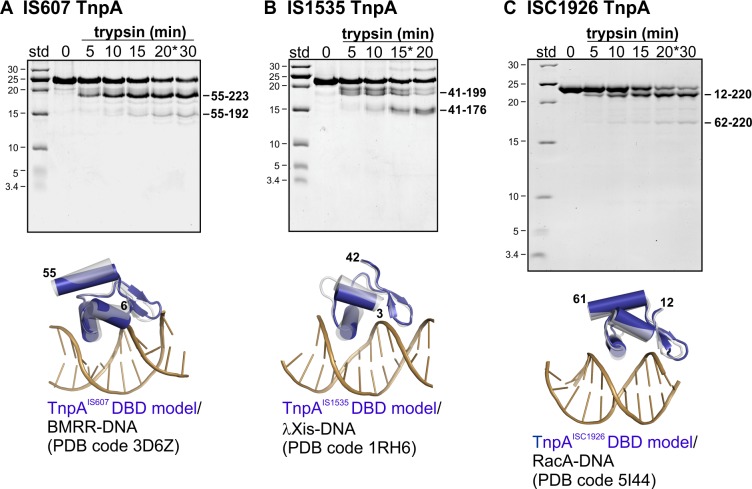
Limited proteolysis and structures of TnpA proteins.(A) TnpAIS607(His6) digested with trypsin and subjected to 18% SDS-PAGE. MALDI-TOF analysis of an aliquot from the 20 min digestion (*) gave a major peak consistent with the mass of a peptide from residue 55 (cleavage at Arg54) to the C-terminus and a second peak consistent with a peptide from Ser55 – Arg192 (located within the predicted turn between the N- and C-terminal segments of helix E). Below the SDS gel is a Phyre2 model of the N-terminal winged-helix domain structure (residues 6 – 55, blue) superimposed over a BMRR-DNA X-ray structure (grey protein, brown DNA; rmsd = 1.44 Å over protein backbone atoms). (B) TnpAIS1535(His6) digested with trypsin. MALDI-TOF analysis of an aliquot from the 15 min digestion (*) gave a major peak consistent with a peptide from residue 41 (cleavage at Lys40) to the C-terminus and a second major peak consistent with a peptide from Thr41 to Arg176 (located close to the turn between the N- and C-terminal segments of helix E). The Phyre2 model of the N-terminal winged-helix domain structure (residues 3 – 42, blue) is superimposed over a phage λ Xis-DNA X-ray structure (grey protein, brown DNA; rmsd = 0.74 Å). (C) TnpAISC1926(His6) digested with 2x the amount of trypsin used above and Ca2+ in the buffer. MALDI-TOF analysis of an aliquot from the 20 min digestion gave a dominant peak consistent with a peptide from residue 12 (cleavage at Arg11) to Lys220 and a second peak consistent with peptides from residues 62/63 (cleavage at Lys61 and Arg62) to Lys220. Cleavage of the linker between the DBD and catalytic domains was much weaker for TnpAISC1926 as compared to TnpAIS607 and TnpAIS1535, which may reflect the short intervening peptide chain. MALDI-TOF/TOF analysis of a different preparation of TnpAISC1926 (purified from an N-terminal SUMO fusion) and different trypsin gave products corresponding to peptides from 1-Lys61 and 1-Arg62 (weak) and Arg62 to the C-terminus. The Phyre2 model of the N-terminal winged-helix domain structure (residues 12 – 61, blue) is superimposed over a RacA-DNA X-ray structure (grey protein, brown DNA; rmsd = 1.41 Å).